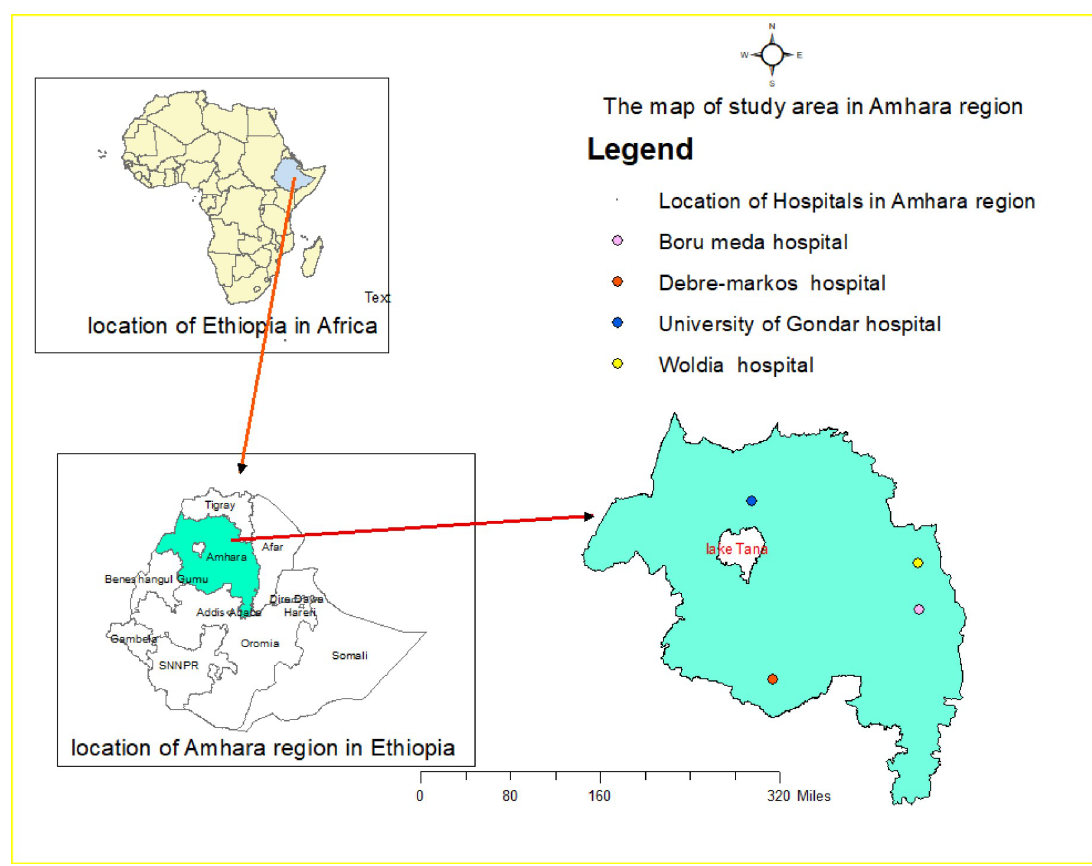
Fig 1. Map of the study area indicating the locations of the four